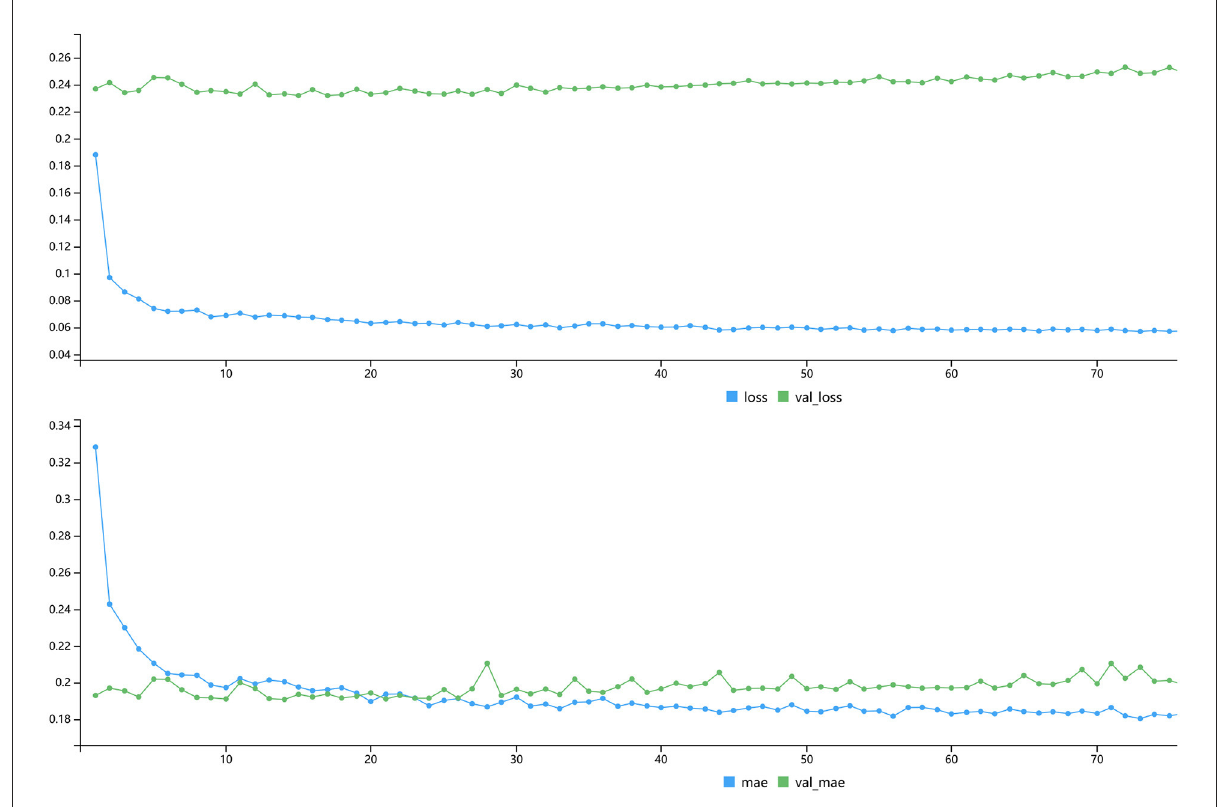
FIGURE4 Plot of LOSS and MAE with